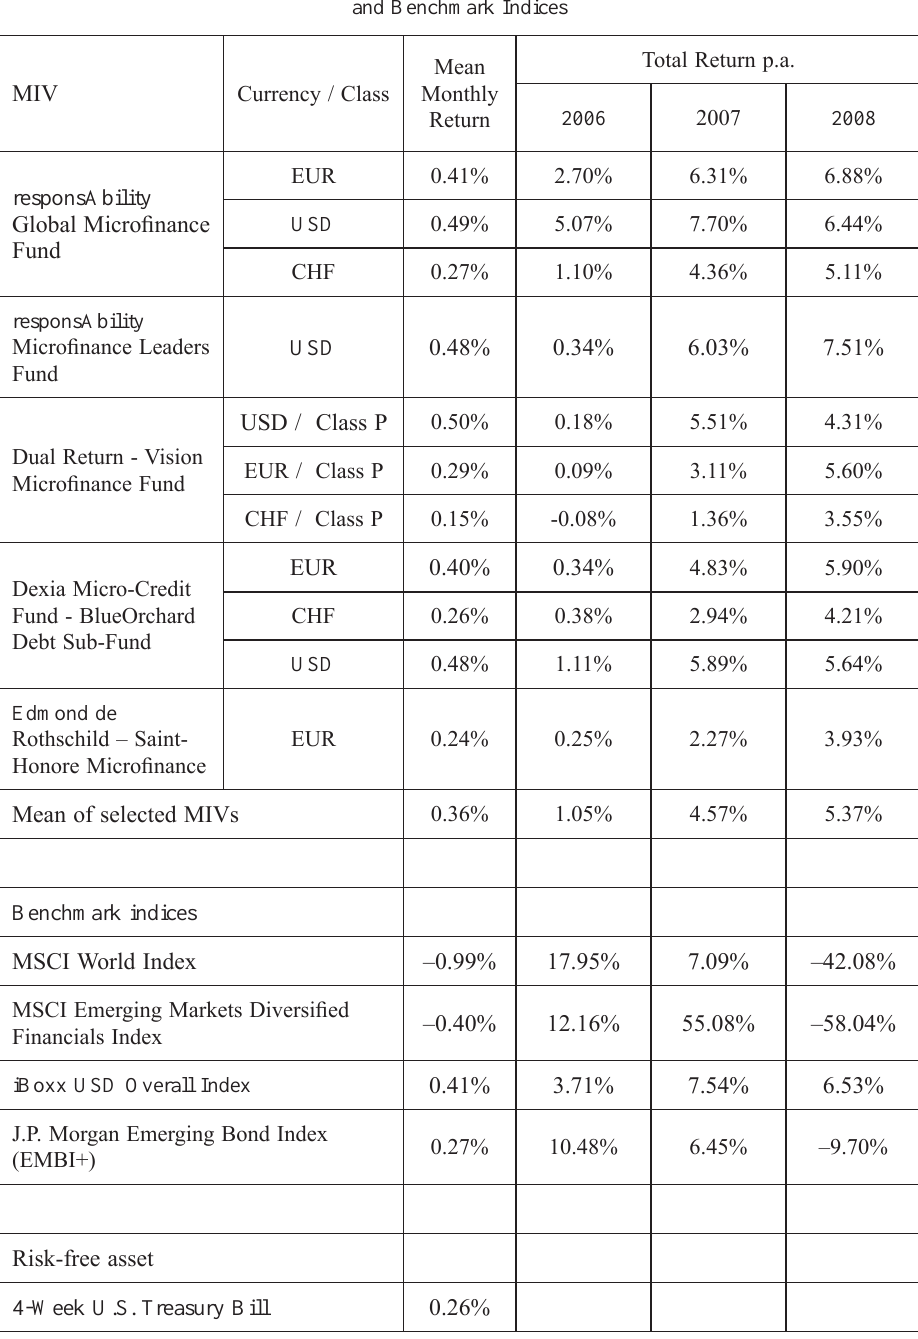
Table 2. Mean Monthly and Total p.a. Returns of Microfinance Investment Funds and Benchmark Indices Mean MIV Currency / Class